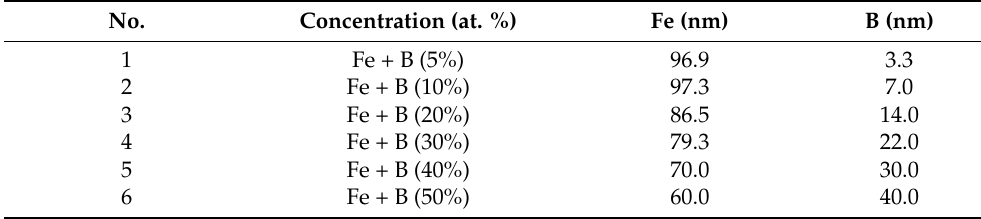
Table 1. Prepared samples, their nominal composition and corresponding effective thickness for each